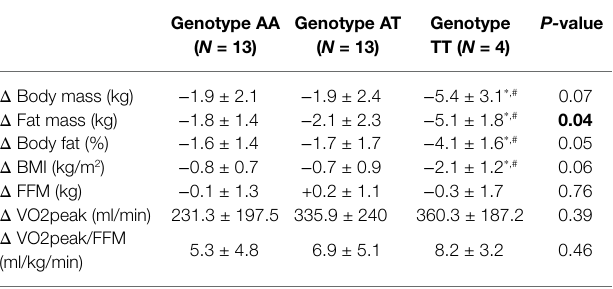
TABLE 5 | Body composition and cardiorespiratory fitness deltas after 12-week exercise intervention according to genotypes for rs1052700 PLIN1 gene polymorphism.